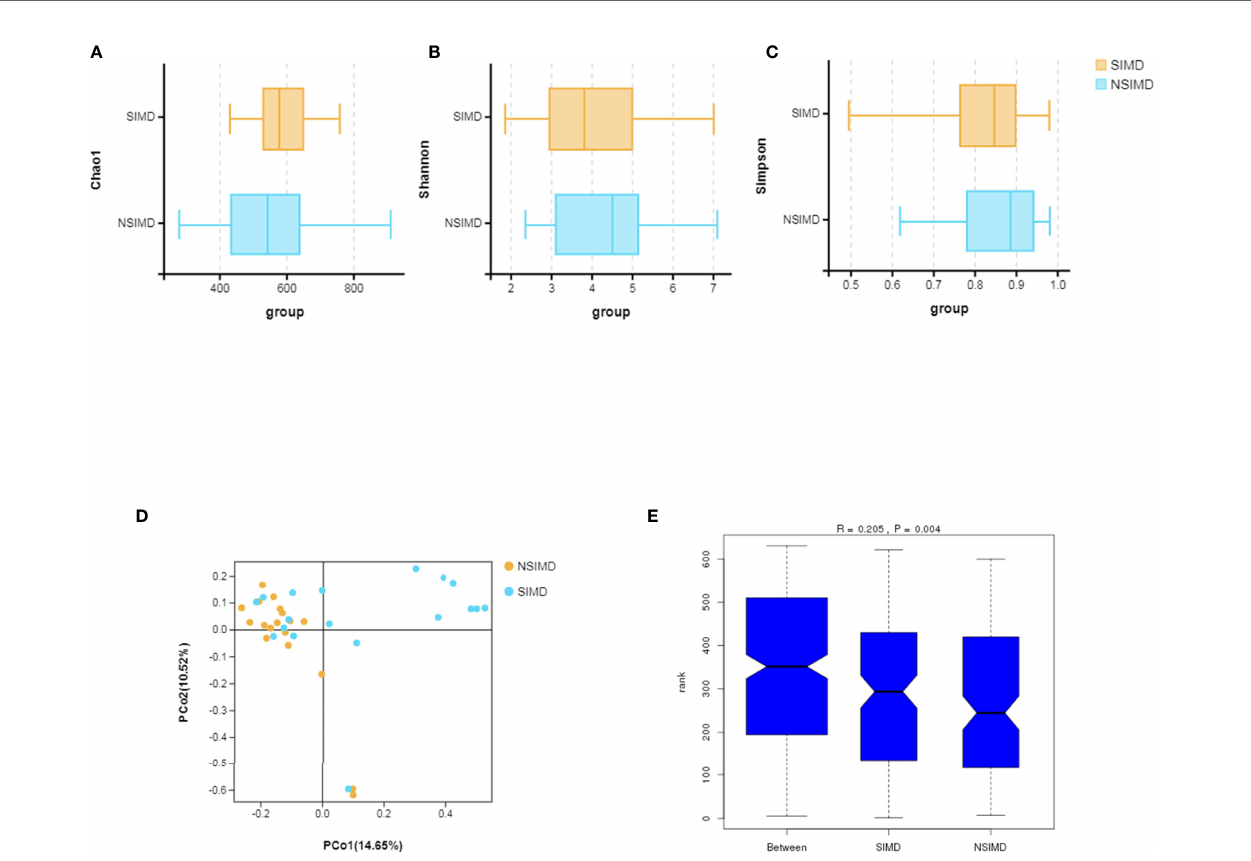
FIGURE 3 | Comparisons of the microbial diversity between the SIMD and NSIMD groups. (A – C) No difference in alpha-diversity between the two groups estimated by Chao1 index, Shannon index, and Simpson index ( p = 0.192, p = 0.355, p = 0.279, respectively). (D) Beta-diversity was calculated using weighted UniFrac by principal coordinate analysis (PCoA), indicating a symmetrical distribution of fecal microbial community among all the samples. (E) Global community was signi fi cantly different using ANOSIM test (R = 0.205, p = 0.004). SIMD, sepsis-induced myocardial dysfunction; NSIMD, non-SIMD; ANOSIM, analysis of